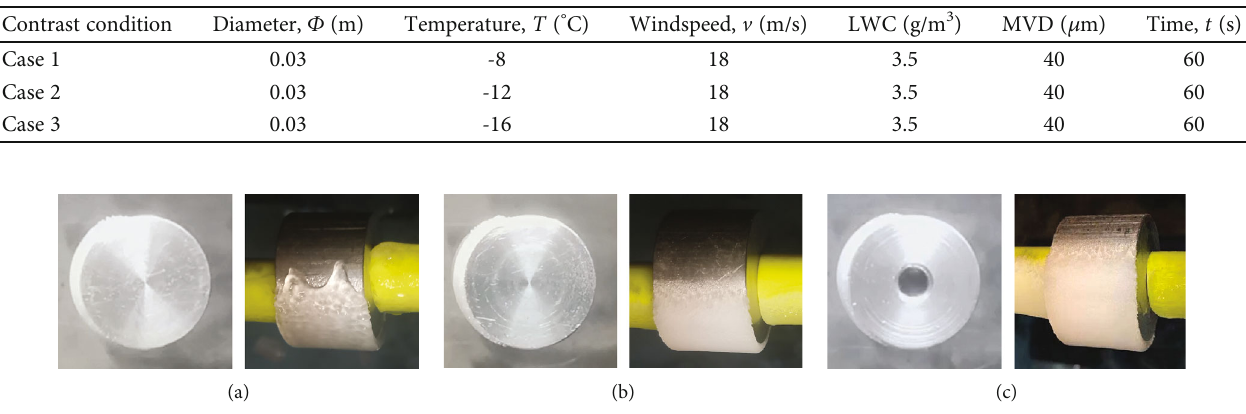
Figure 10: The icing types on a cylinder surface: (a) glaze ice, (b) mixed ice, and (c) rime ice.